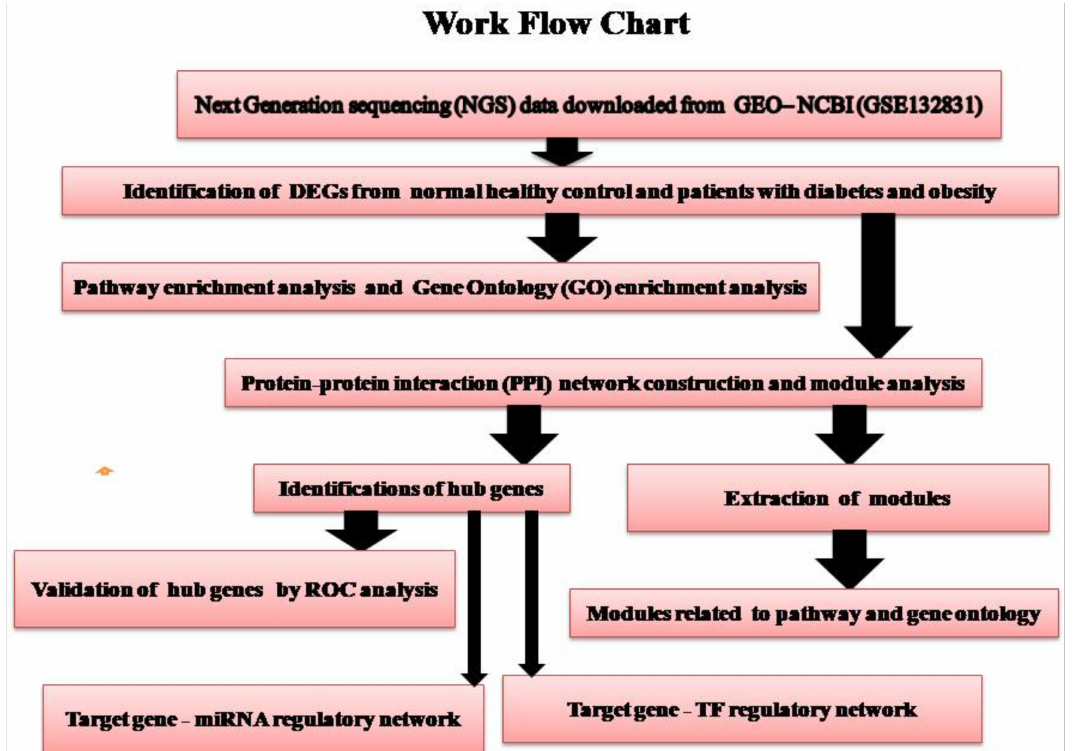
Figure 1. Overview of data analysis